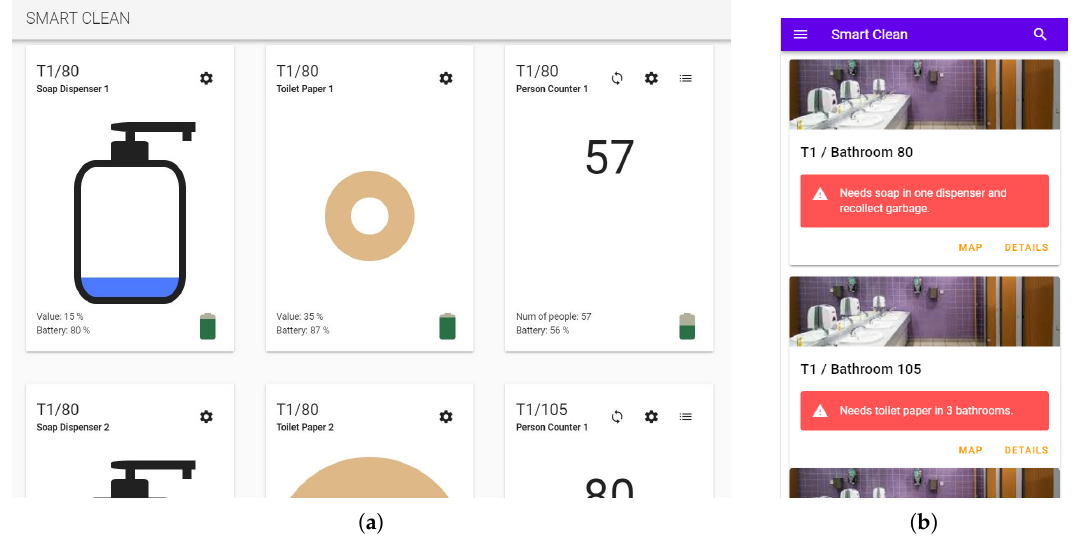
Figure 15. Application details. ( a ) real time monitor, ( b ) mobile application.